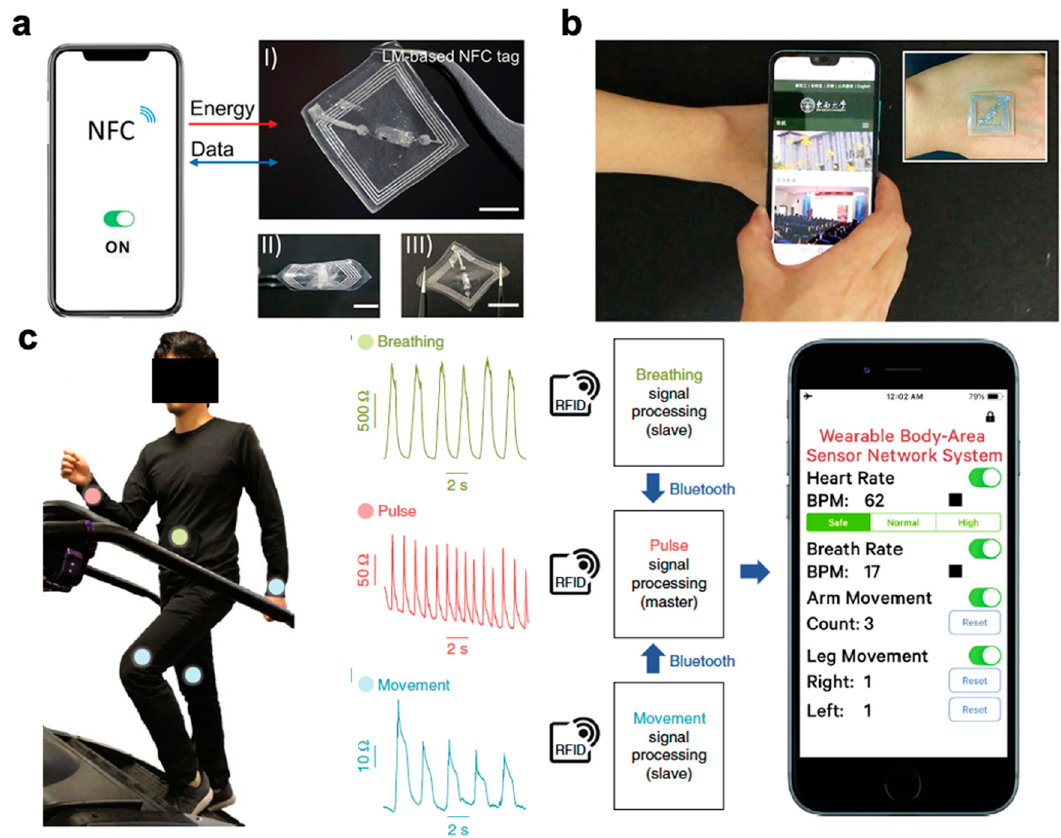
Figure 24. ( a ) Liquid metal-based hydrogel NFC tag with demonstrated use ( b ). Reproduced with permission from [111]. Copyright 2020 John Wiley and Sons. ( c ) Demonstration of bodyNET system with corresponding signal outputs for breathing, pulse, and arm movement. Reprinted with permission from [238]. Copyright 2019, Springer